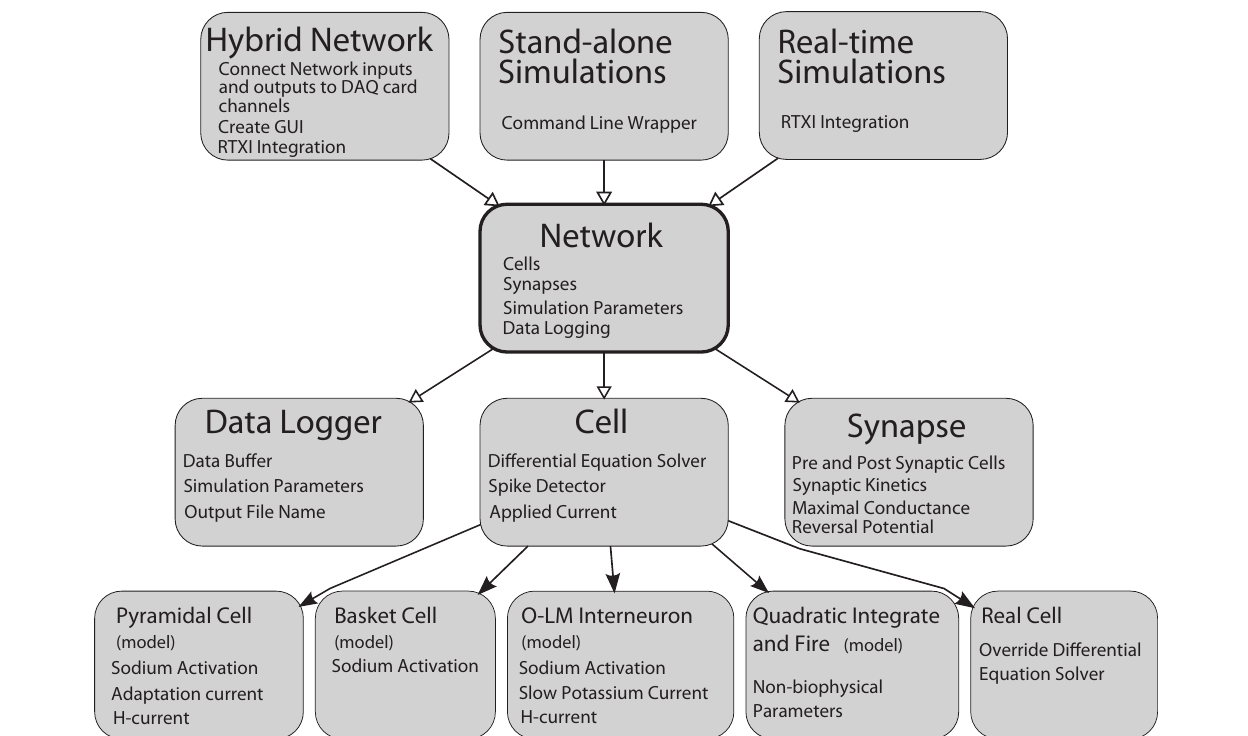
can be biophysical or non-biophysical if desired. The Network class is “wrapped” by three helper classes that allow the core of GenNet to be used in three different contexts. In one, GenNet is coupled to RTXI and physical hardware channel inputs are routed between model cells and real cells in an experimental preparation. In the other context, the simulator runs “stand-alone” in a purely virtual mode. In the last, GenNet is embedded within RTXI but used for real-time, single-cell simulations rather than hybrid network applications. All cells marked (model) are computer model versions of the cells they represent. The “real cell” is a placeholder class that serves to represent a living neuron within